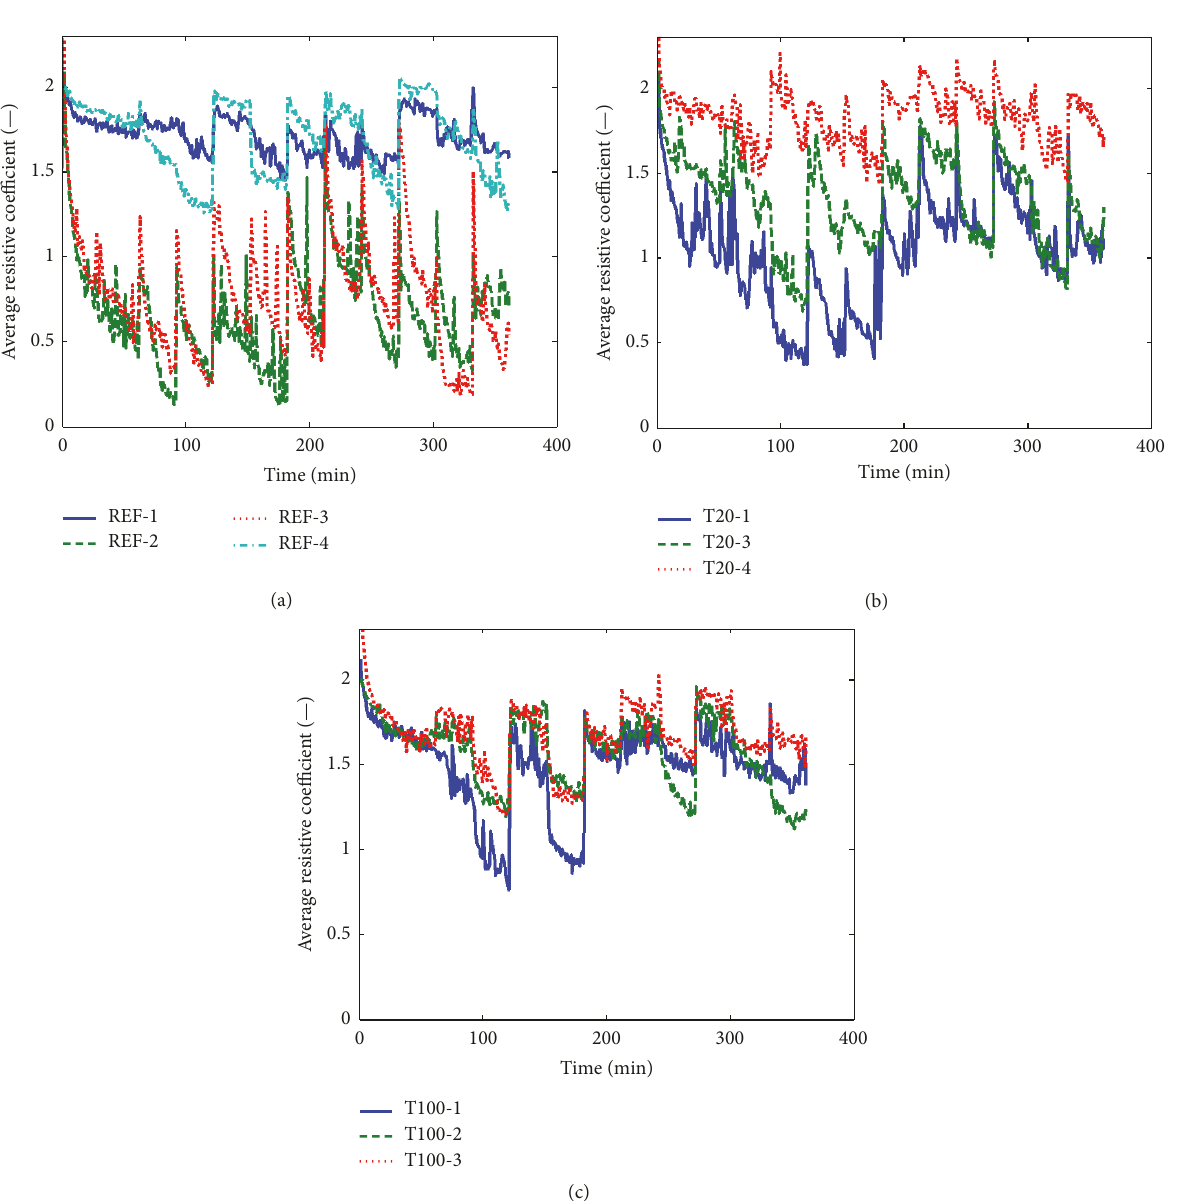
for the plateau (nontextured) part of the surface times the plateau area